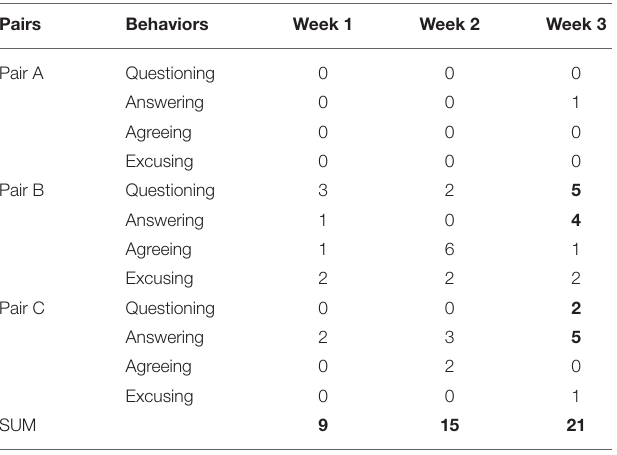
TABLE 3 | The frequency of the students’ verbal behaviors in the learning of piano timbre. Pairs Behaviors Week 1 Week 2 Week